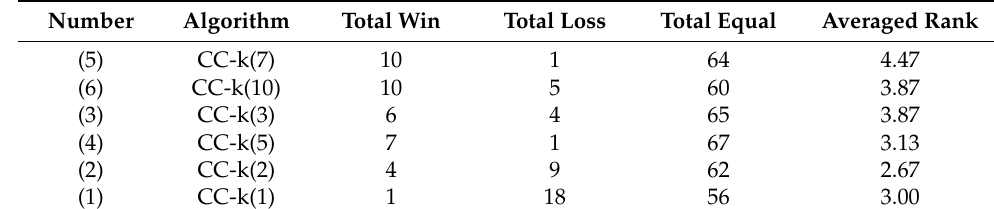
Table 4. The sum of the Wilcoxon test results.